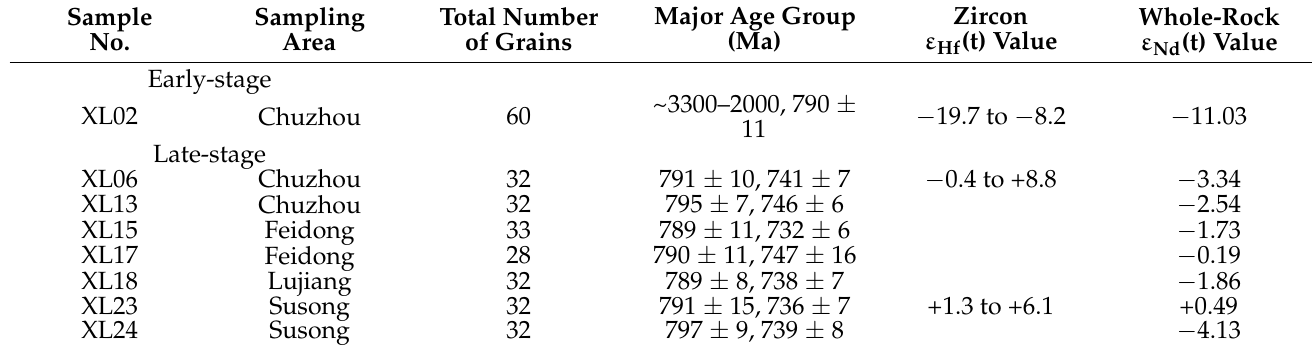
Table 1. Summary of zircon ages and Nd-Hf isotopic compositions for volcanic rocks of the Xileng Formation in the Zhangbaling